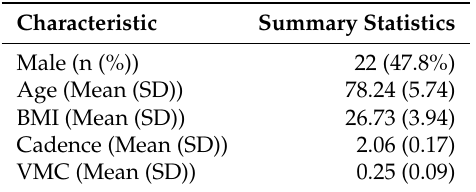
Table 1. DECOS participant characteristics ( N =